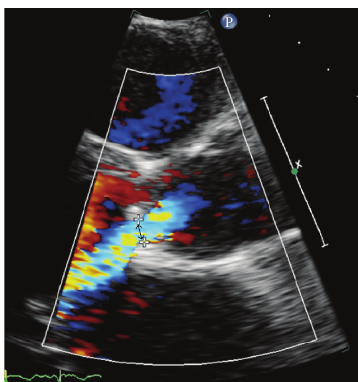
Figure 1: Color doppler evaluationof the aortic valve regurgitation: the arrow points to “vena contracta” of a central severe regurgitant